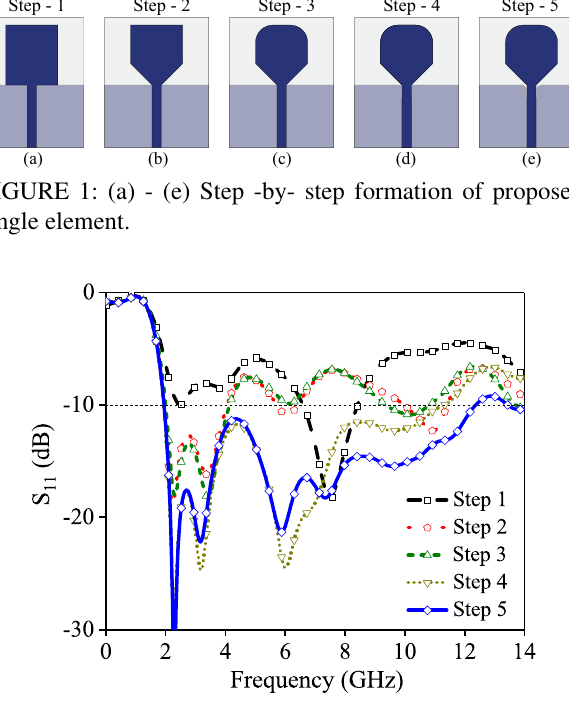
FIGURE 2: Intermediate steps effect on reflection coefficient.